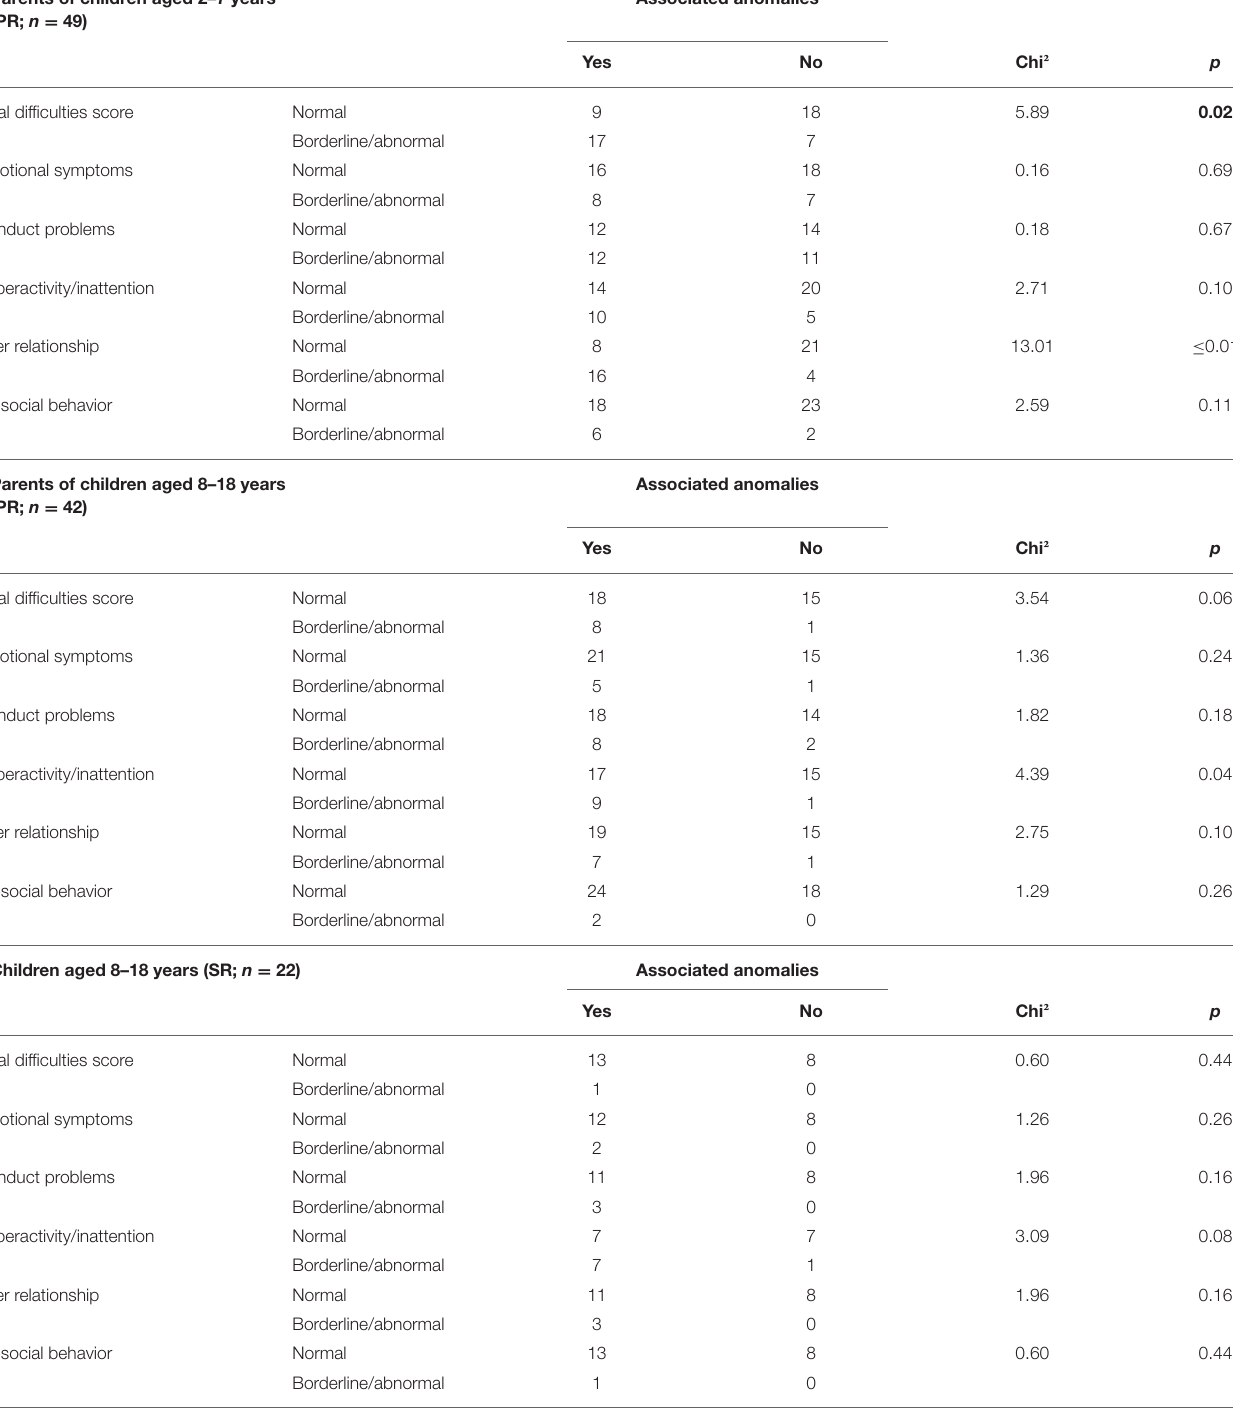
TABLE 3 | Comparison of SDQ-classifications for EA patients with an without associated anomalies. Parents of children aged 2–7 years (PR; n =